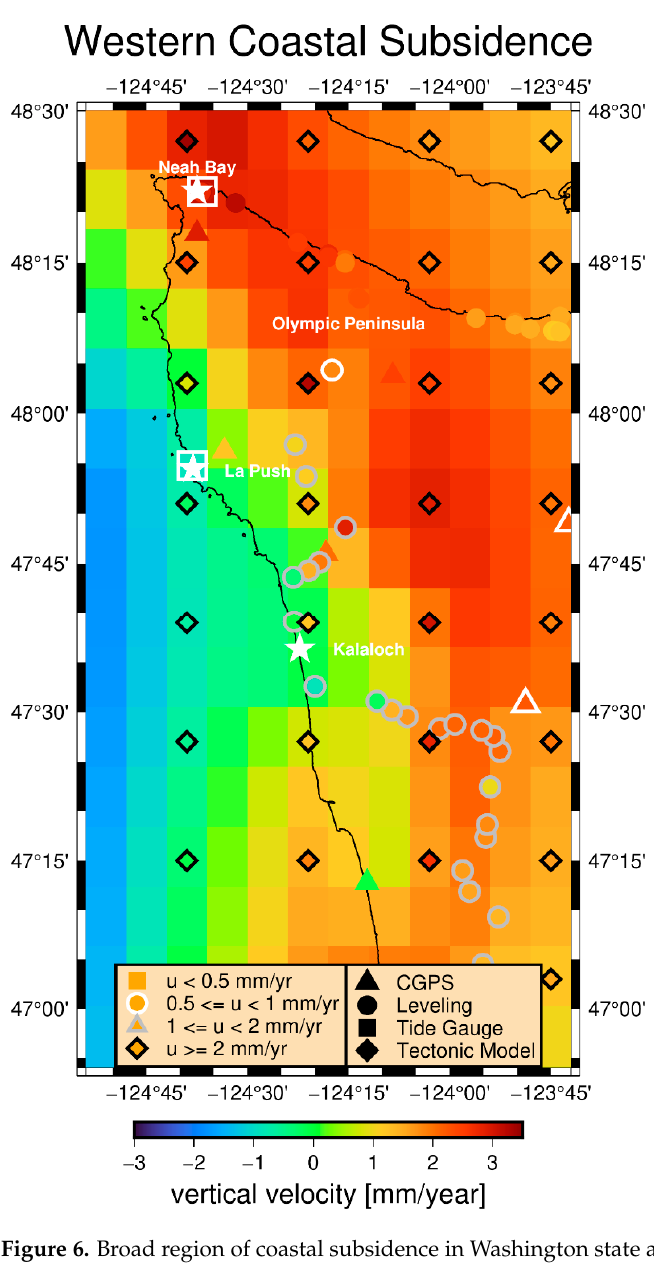
Figure 6. Broad region of coastal subsidence in Washington state along the western Olympic Peninsula. Shown also are vertical rate estimates extracted from the tectonic model, and measurements of vertical land movement derived from CGNSS, leveling, and tide gauges, expressed as millimeters per year (mm/yr). Data type is denoted by marker shape, vertical velocity is denoted by marker color, and uncertainty is denoted by marker outline. North is up.